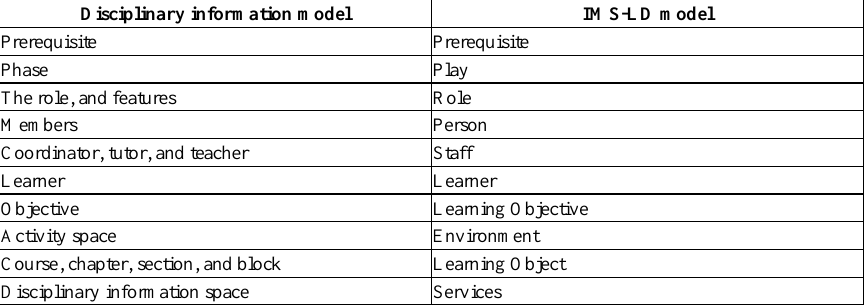
Table 1. Correspondence between the terminology of IMS-LD and that of the